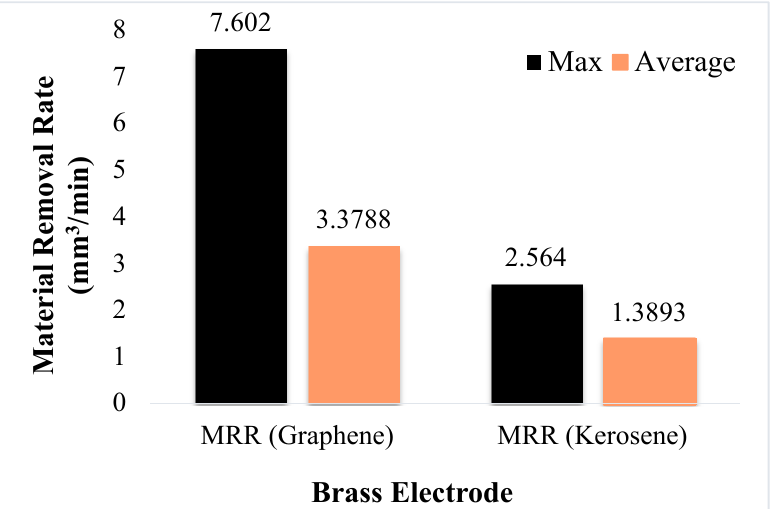
Figure 10. Comparison of MRR obtained in graphene-mixed and kerosene dielectric for brass elec- trode.